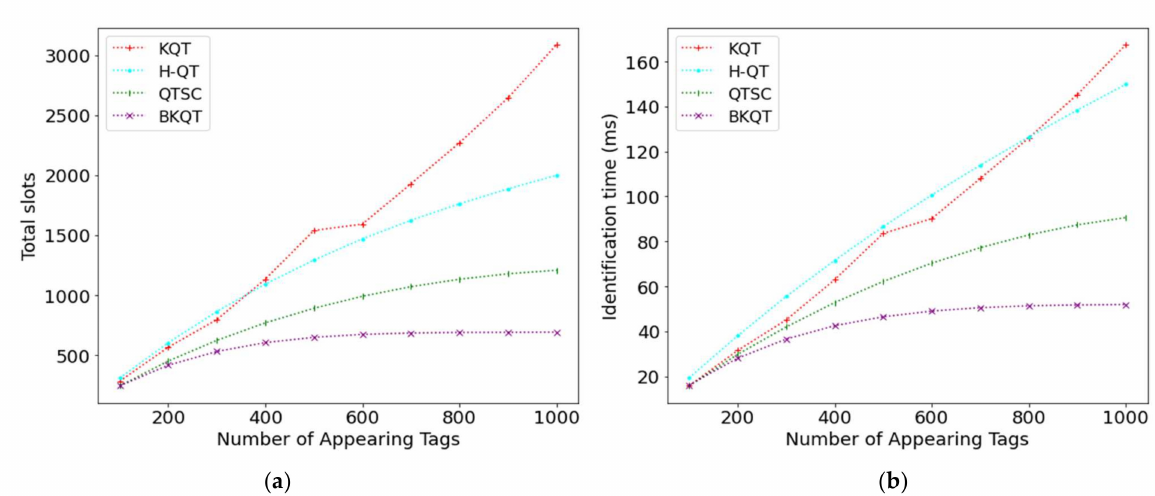
Figure 2. Total slots and identification time subject to the number of appearing tags. ( a ) Total slots, ( b ) Identification time.